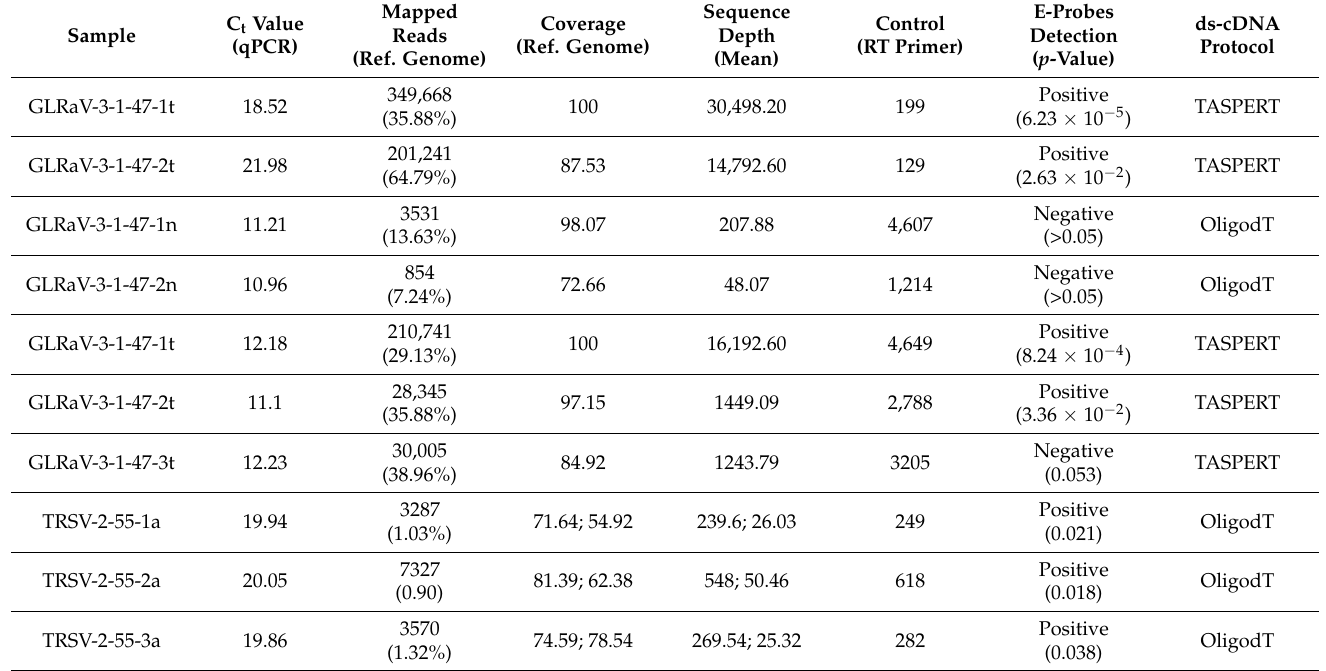
Figure 1. TASPERT method layout showing the sample RNA extraction from infected tissue ( top left ), the RT-primer design ( bottom left ), and the virus-specific ds-cDNA synthesis ( right ). Short colored strands in the RNA extraction section represent viral RNA from different plant viruses, while longer gray strands represent host RNA. FAP are colored black at the 5 ′ of the RT-primers, and the virus-specific segments are represented with different colors. A degenerate nucleotide representing (A/C/G) is also represented in black at the 3 ′ -terminus of the RT-primers. Only the virus sequences are enriched during ds-cDNA synthesis using the TASPERT RT-primers ( center-right ). The final TASPERT product is ready for library preparation and sequencing with any HTS platform. Table 2. Double-stranded cDNA concentrations generated using the TASPERT protocol and the NEBNext Single Cell protocol. The RT primers for TASPERT were TSO-GLRaV-3-a and dTRSVTSO for GLRaV-3 and TRSV, respectively. Double- stranded cDNA was measured with Quantus, and pathogen detection was performed using qPCR, read mapping, and e-probes. The control RT primer was used to determine if cross contamination